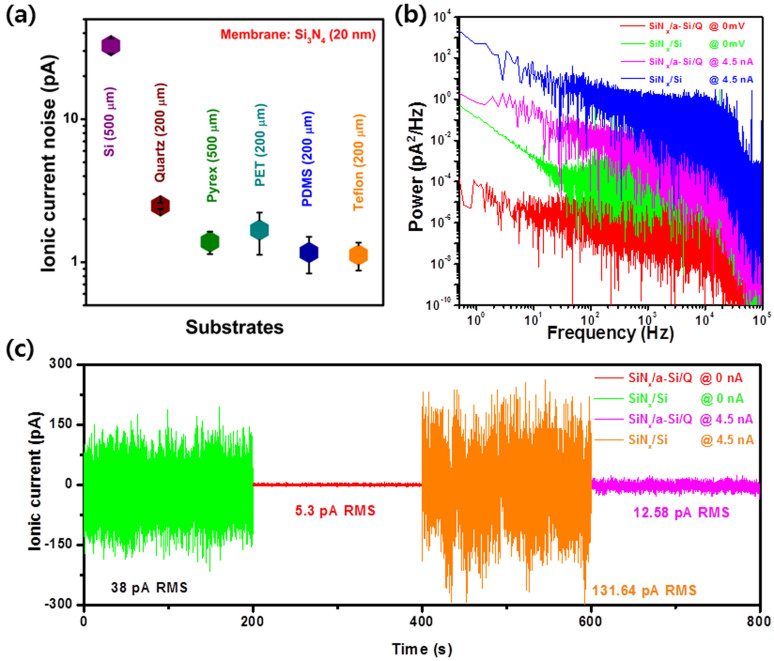
Ionic current noise in quartz-substrate-based nanopore.(a), RMS ionic current noise through 20-nm-thick SiNx membrane on various substrates. (b), Power spectrum of SiNx 20 nm on Si and a-Si 200 nm/quartz 200 μm measured in 1 M KCl while maintaining a pore current of 0 and 4.5 nA, respectively. (c), Baseline ionic current noise traces corresponding to the PSD curved structures described in (b).